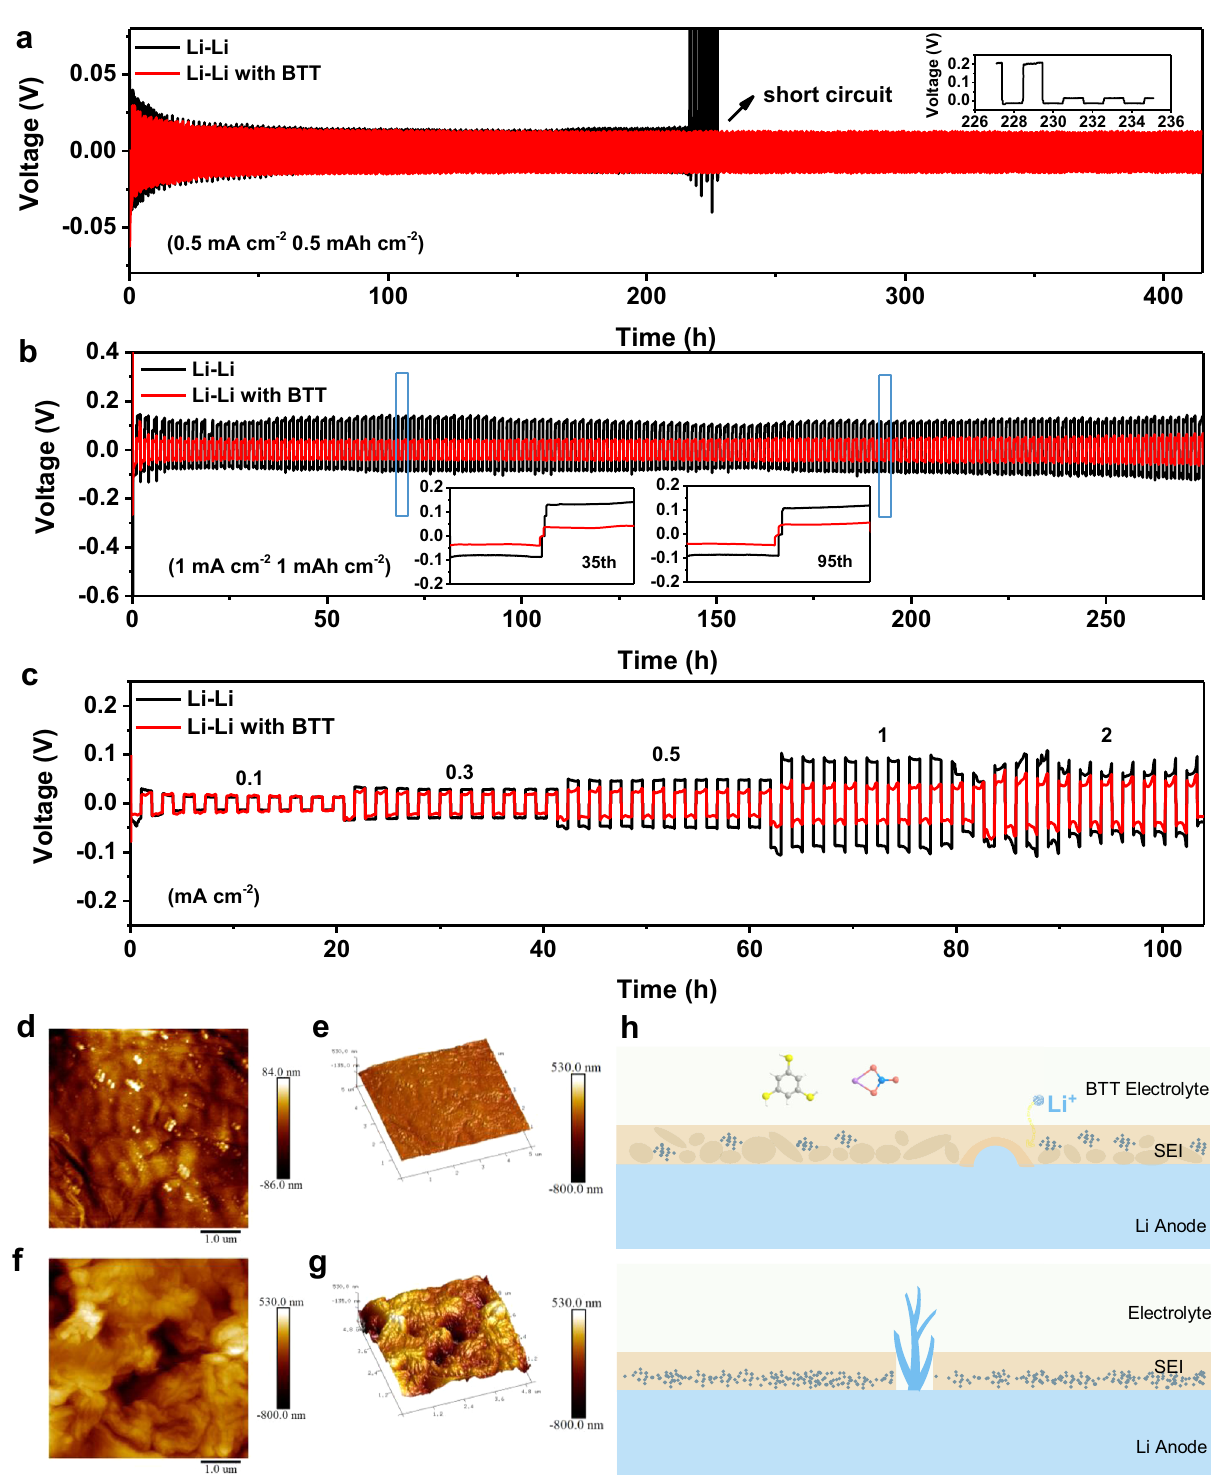
Fig. 2 Long-term cycling performance of the symmetric Li – Li cells with BTT and blank electrolyte. a Plating and stripping curves for the two types of symmetric cells with a current density of 0.5 mA cm − 2 and a capacity density of 0.5 mAh cm − 2 . b Both types of cells at a current density of 1 mA cm − 2 and a capacity density of 1 mAh cm − 2 . c Both types of cells at various currents and the cells cycled under 1 h charge and discharge conditions. d , e AFM images for the lithium foil with BTT electrolyte after 100 cycles with a current density of 0.5 mA cm − 2 and a capacity density of 0.5 mAh cm − 2 . f , g AFM images for the control cell. h Schematic diagram of the fl exible organic-inorganic SEI in BTT electrolyte and dendrite lithium in blank